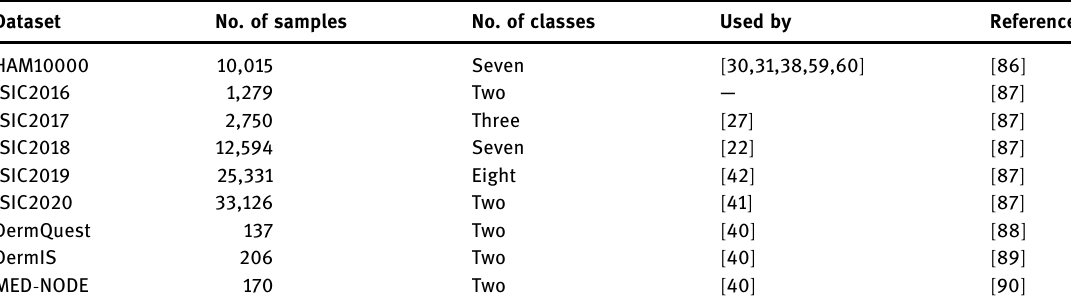
Table 5: Skin cancer datasets